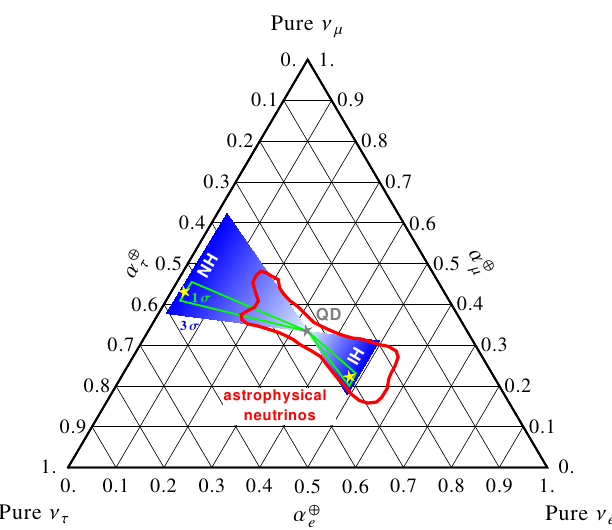
Figure 3 . Majoron DM decay J ! (cid:23)(cid:23) yields neutrino (cid:13)avor ratios (cid:11) e : (cid:11) (cid:22) : (cid:11) (cid:28) that depend on the neutrino mass hierarchy. The 1 (cid:27) (3 (cid:27) ) ranges of the neutrino-oscillation parameters from ref. [42] correspond to the green (blue) lines; lighter colors correspond to a larger lightest-neutrino mass, converging to 1 : 1 : 1 for the QD spectrum. The three stars denote the benchmark values of eq. (3.5). The expected (cid:13)avor ratios from realistic astrophysical processes (e.g. pion decay followed by averaged-out neutrino oscillations) fall in the red contour, taking into account the uncertainties in the mixing parameters (95% C.L.)